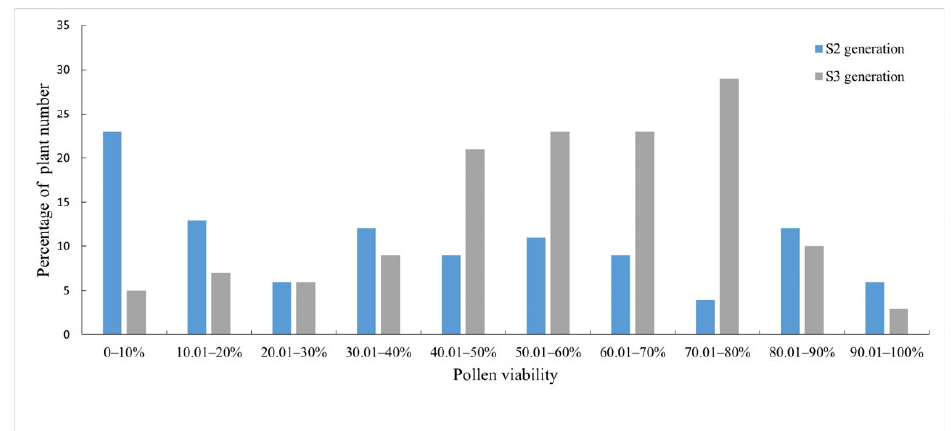
Figure 6. Statistical result of pollen viability in S 2 and S 3 generation derived from an allohexaploid Brassica hybrid H16-1.